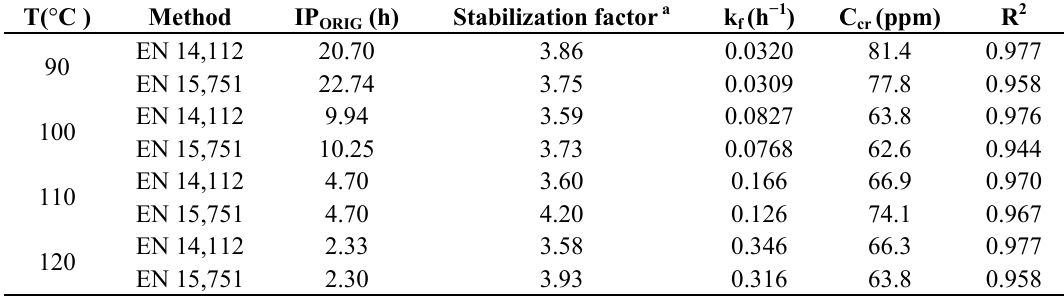
and stabilization factor, k Table 3. The IP ORIG biodiesel blend at various temperature according to EN1411 and